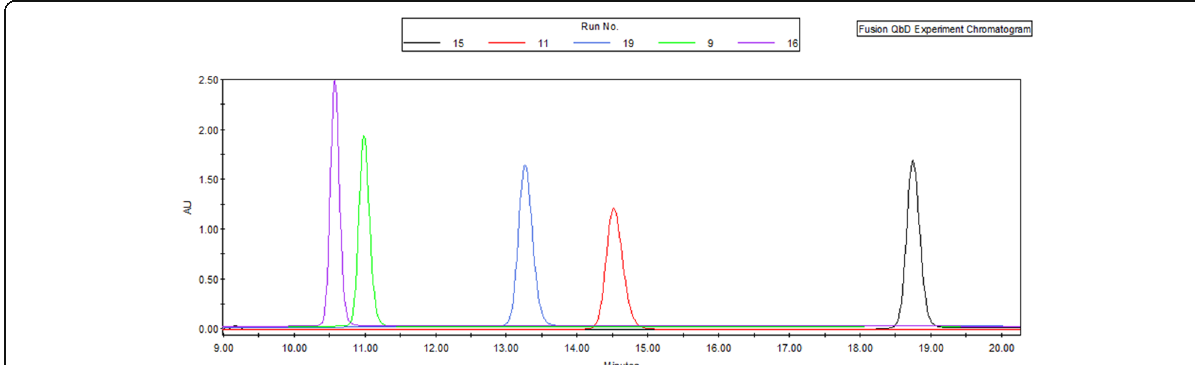
Fig. 4 Effects of final percentage of strong solvent and flow rate on the API peak area and peak height: run 15 (black) = 31%/0.9 mL/min; run 11 (red) = 33%/1.0 mL/min; run 19 (blue) = 35%/0.9 mL/min; run 9 (green) = 37%/1.0 mL/min; run 16 (purple) = 39%/0.9